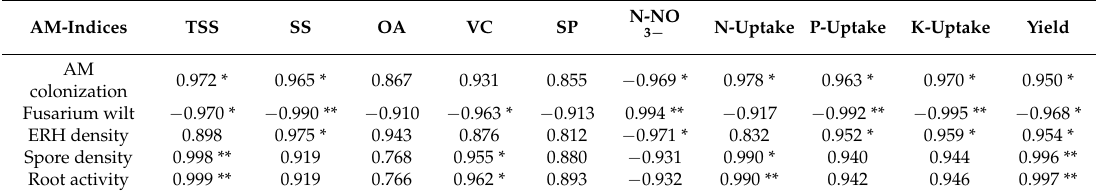
Table 6. Correlation analysis of AMF development with cucumber fruit